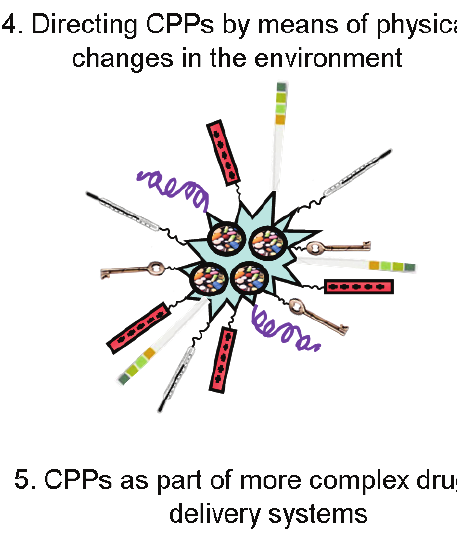
Figure 1. Strategies used to achieve cell